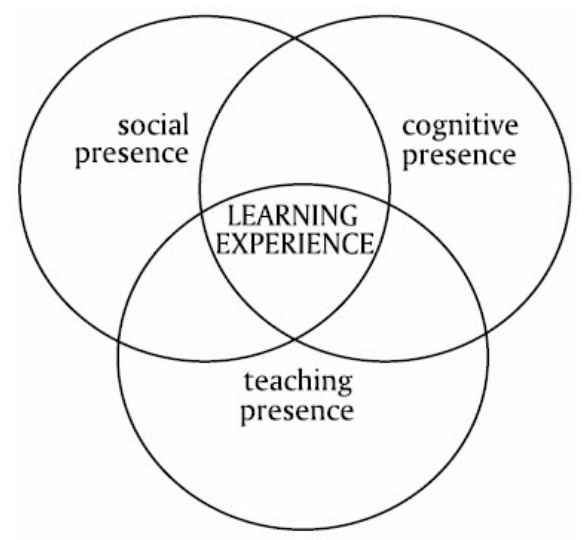
Figure 1. Community of inquiry